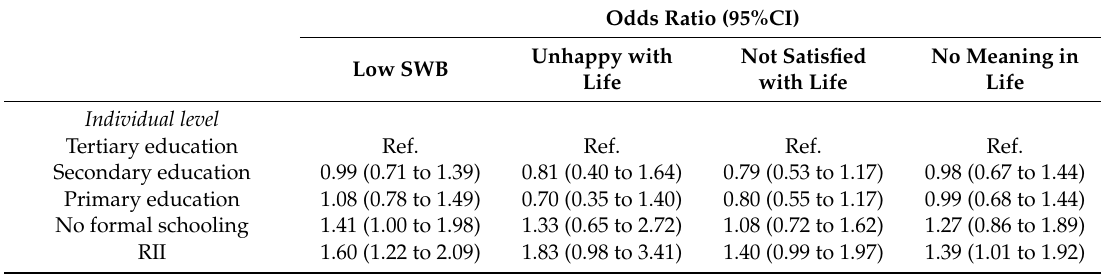
Table 3. Multilevel associations of education and components of and overall subjective well-being.